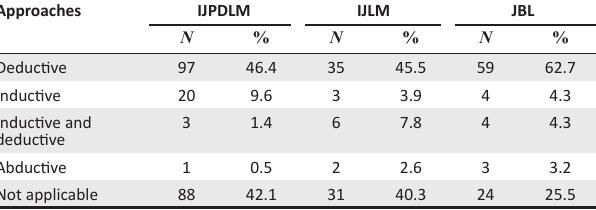
TABLE 1: Logistics-related theories and their corresponding disciplines (1980–1996). TABLE 2: Research approaches identified in three major journals